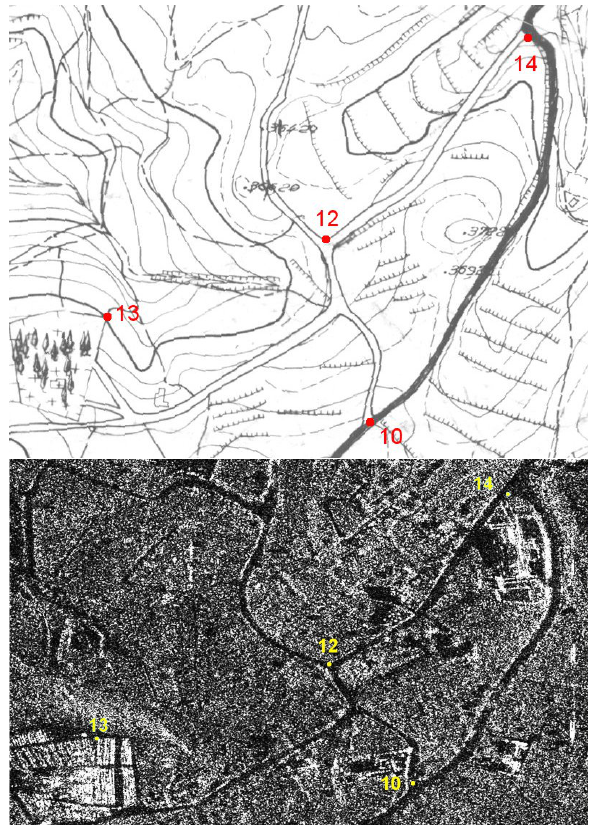
Figure 3. Some homologous GCPs on the map (top) and on the TerraSAR-X image (bottom).